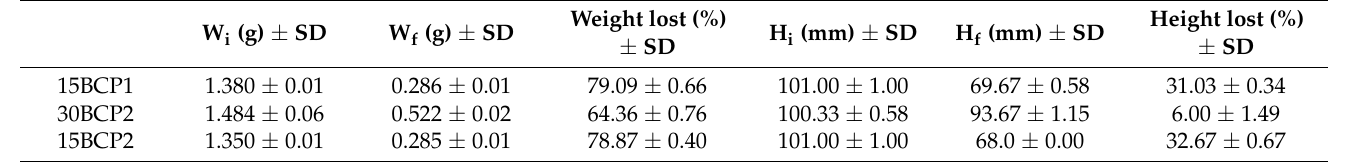
Table 2. Weight (W) and height (H) loss of dehydrated 3D-printed